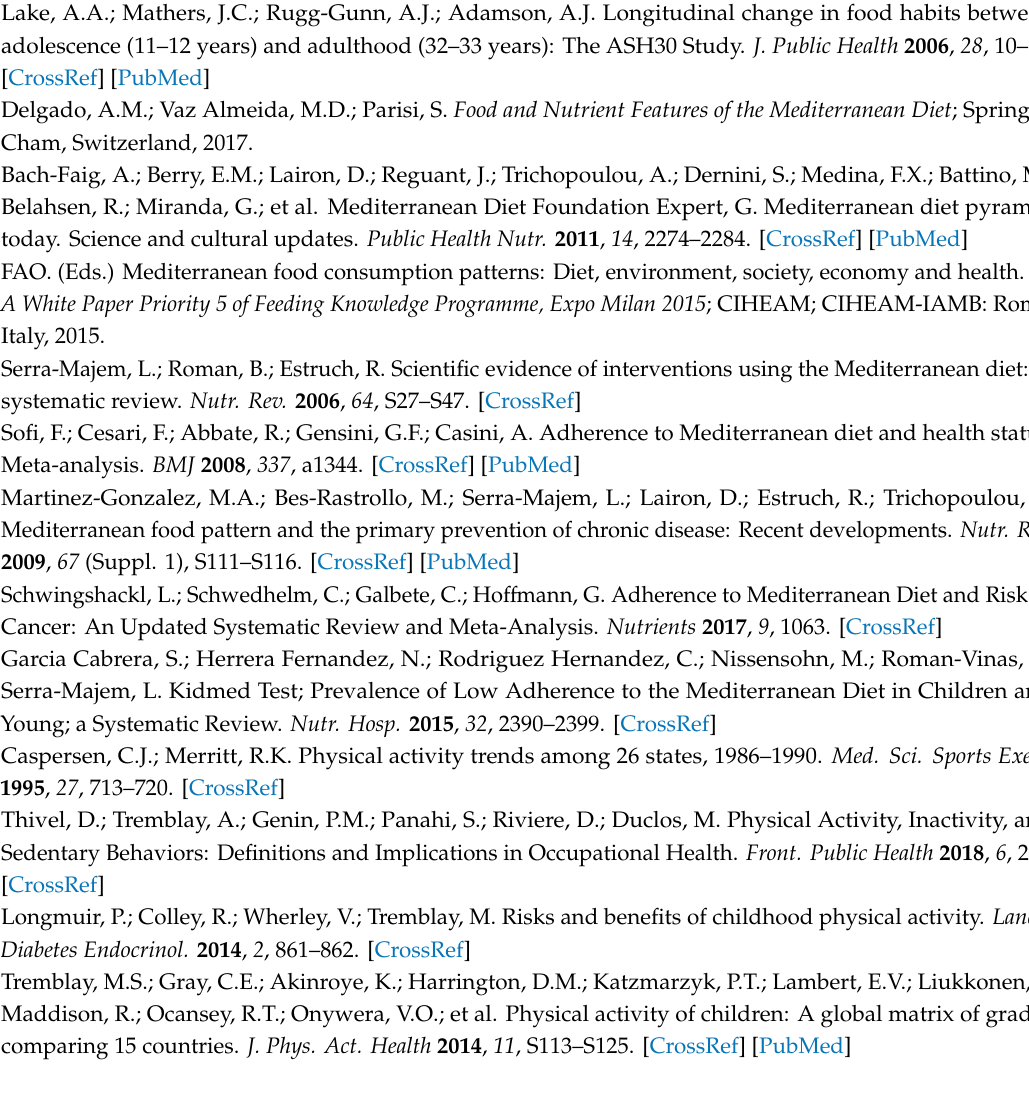
Table S1: Medical, nutritional and physical activity history, Table S2: KIDMED test to assess the Mediterranean diet